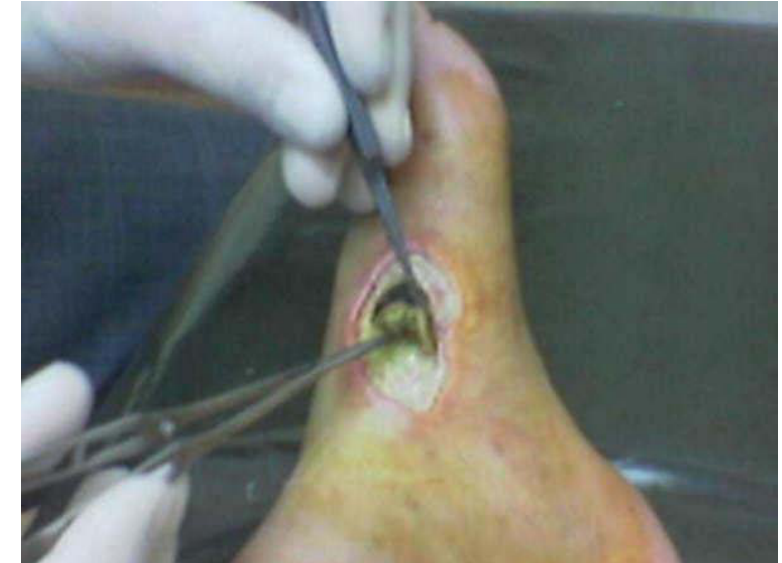
Figure 4. The operation before (3 days) the skin